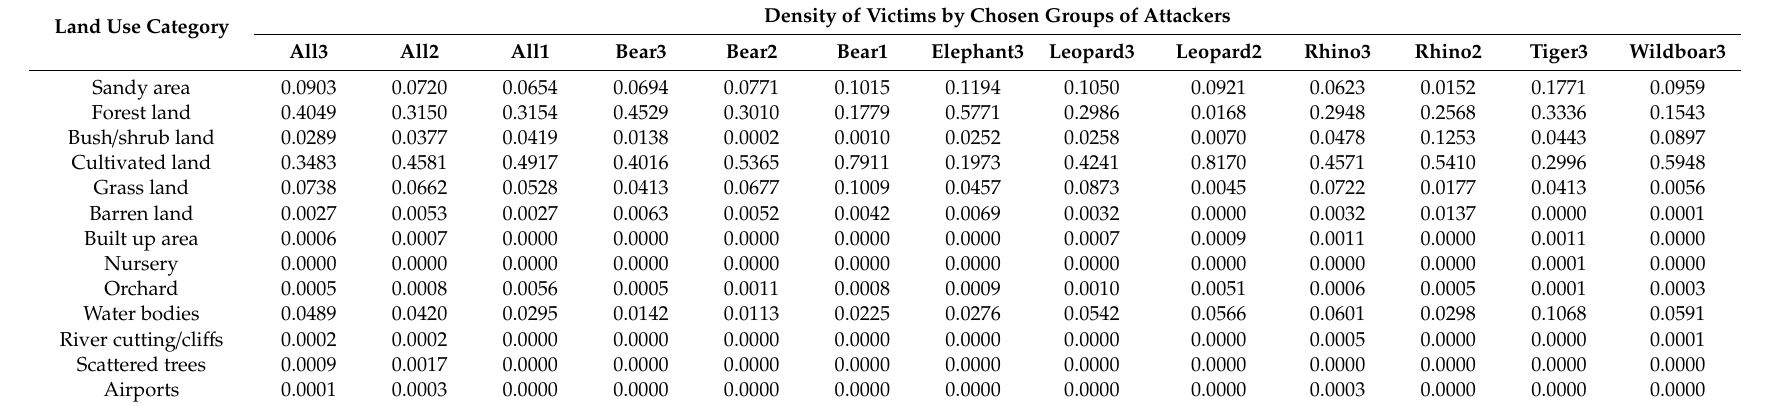
Table 2. Pearson’s correlation coe ffi cient ( r > 0.3 shown in bold) between areas in sq. km of di ff erent concentrations of HWCs and land use category ( animal name_1